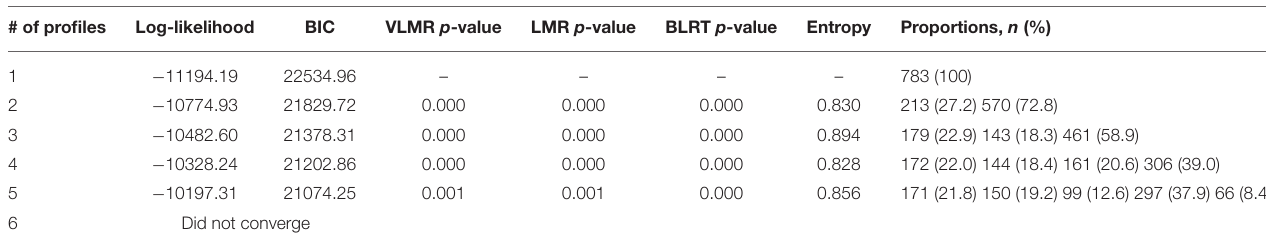
TABLE 3 | The results of latent profile analyses of nature exposure and outdoor